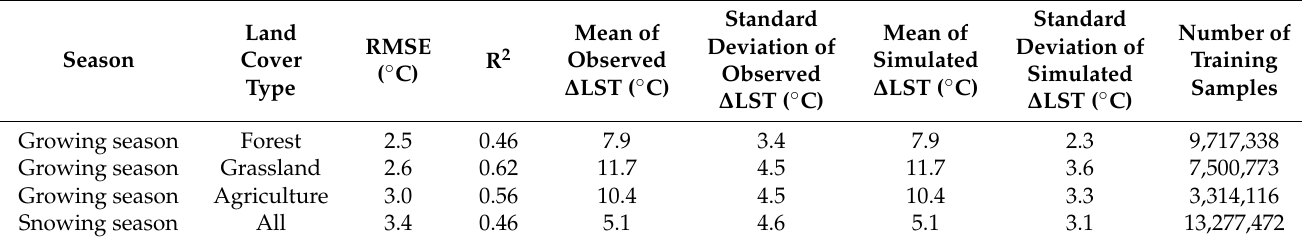
Table 3. Sample numbers and performance of four GAM models. All models are statistically significant ( p <